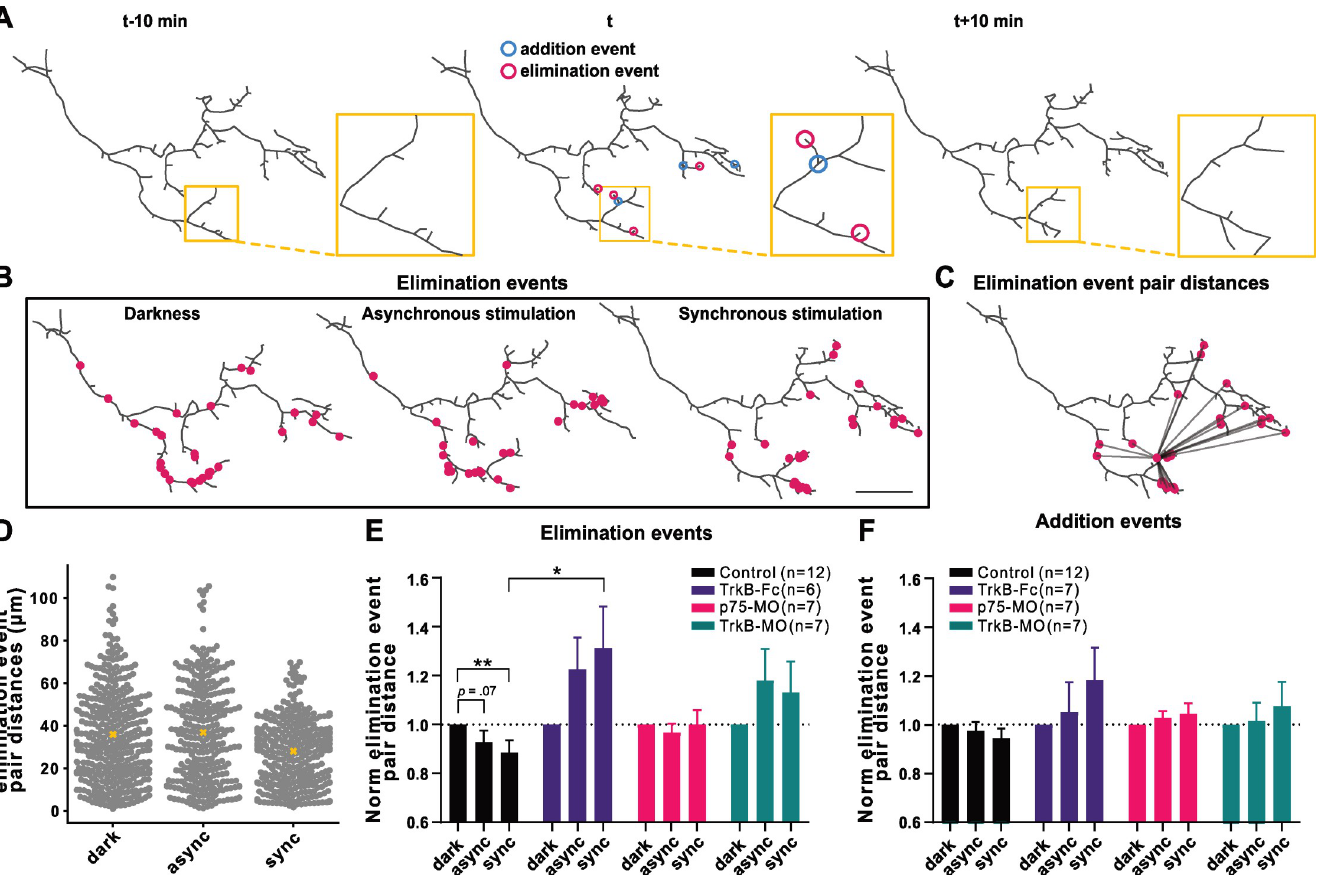
Fig 2. Role of BDNF signaling in local branch elimination induced by synchronous stimulation in ipsilaterally projecting RGC axons. (A) Three consecutive reconstructed arbors from a control ipsi axon during synchronous stimulation. Addition and elimination event locations (for time point “ t ”) are defined as the coordinates of the branch point of the newly added axonal branch ( � 1.5 μ m) between t-10 min and t (blue), or terminal point of a lost branch between t and t+10 min (magenta), respectively. (B) All elimination events during DAS (1 h, 1.5 h, 1.5 h) are superimposed on the reconstructed arbor (last time point of each stimulation period). (C) Illustration of distances between an elimination event and all the other elimination events (pair distances). (D) All the elimination event pair distances for the axon from (B). Means are denoted as yellow crosses. Normalized branch (E) elimination and (F) addition event pair distances. To correct for changes in arbor size, each point represents the ratio of observed-to-randomized ( S4 Fig ) mean event pair distances, normalized to darkness for each axon. Interaction in the two-way mixed design model: (E) p < 0.001; (F) p = 0.0562. Post hoc tests corrected for multiple comparisons (BKY two-stage linear step-up procedure): * p � 0.05, ** p � 0.01. (E, F) Data are shown as mean + SEM. (E, F) Control ( n = 12), (E) TrkB-Fc ( n = 6), (F) TrkB-Fc ( n = 7), (E, F) p75-MO ( n = 7), (E, F) TrkB-MO ( n = 7). (B) Scale bar: 20 μ m. The data used to generate Fig 2E and 2F can be found in S3 Data. BDNF, brain-derived neurotrophic factor; DAS, Darkness-Asynchronous-Synchronous; RGC, retinal ganglion